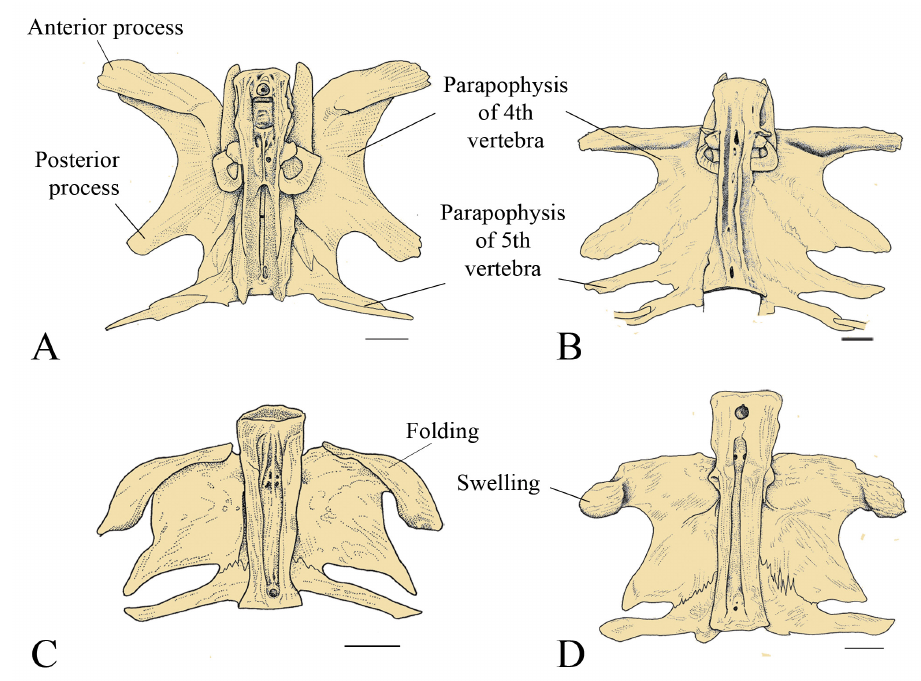
FIGURE 8 | Ventral view of complex vertebrae; anterior up: A. Ictalurus punctatus , MZUEL 13834; B. Steindachneridion scriptum , MZUEL, 19302; C. Pseudopimelodus mangurus , MZUEL 17286; D. Lophiosilurus alexandri , MZUEL 5542. Scale bar = 5